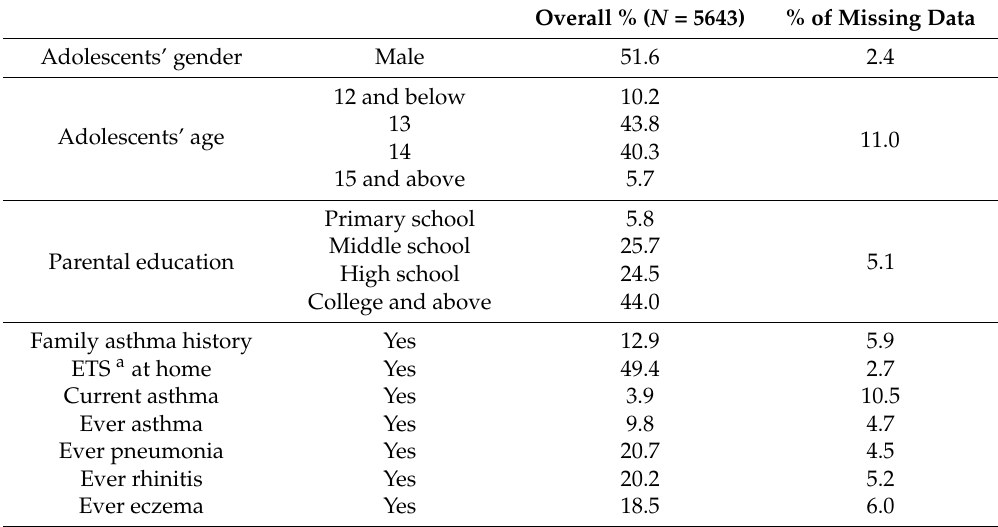
Table 1. Distribution of demographic characteristics and prevalence of outcomes.